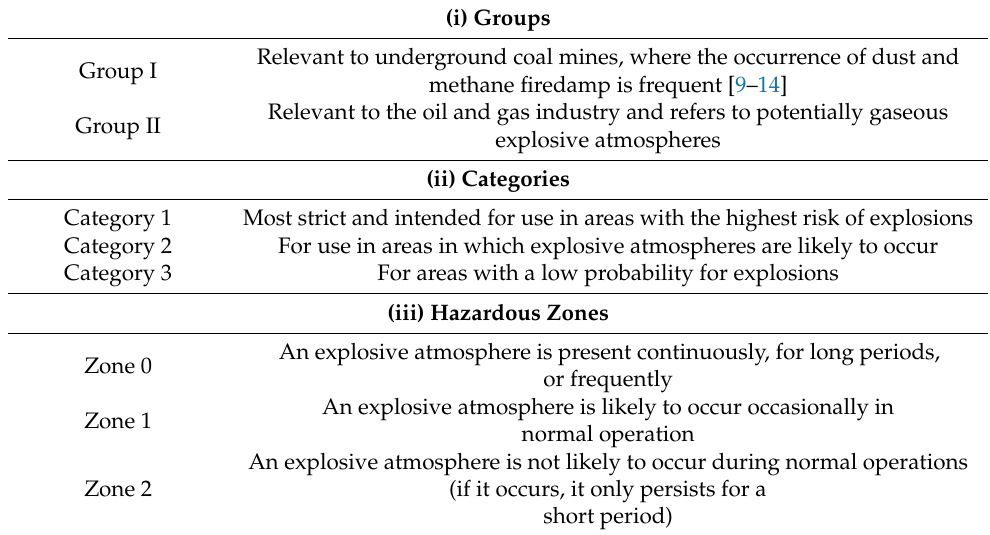
Table 2. Groups, Categories, and Zones prescribed by the “ATmosphere EXplosible” (ATEX) directive.